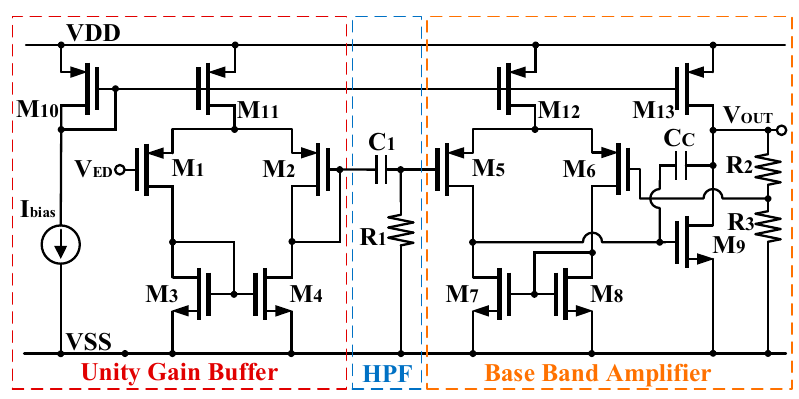
Figure 10. Schematic of proposed IF amplifier.